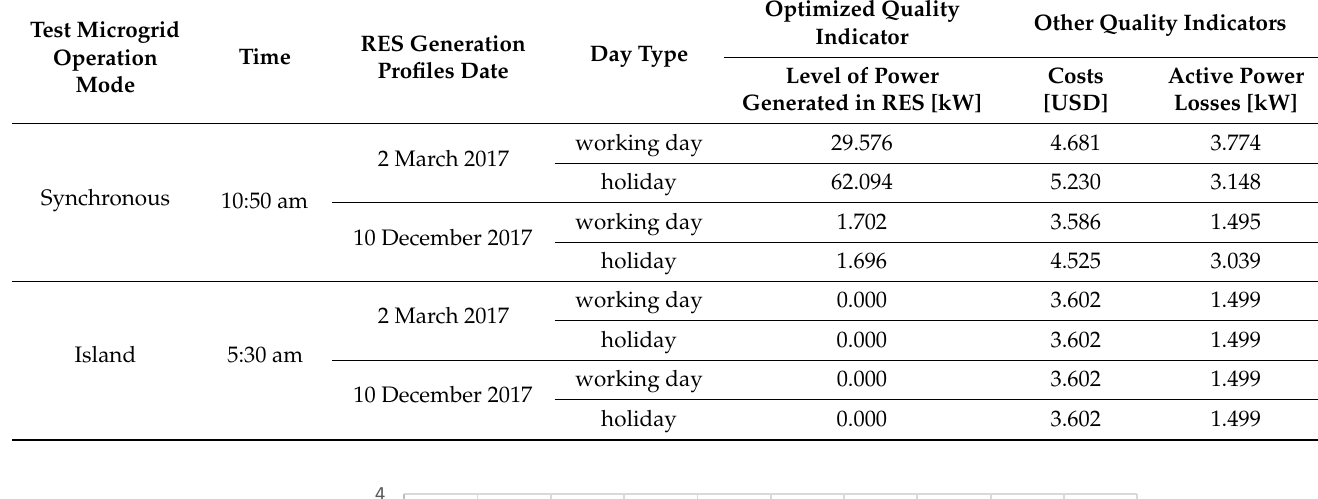
Table 6. Selected results of optimization calculations in task 3.